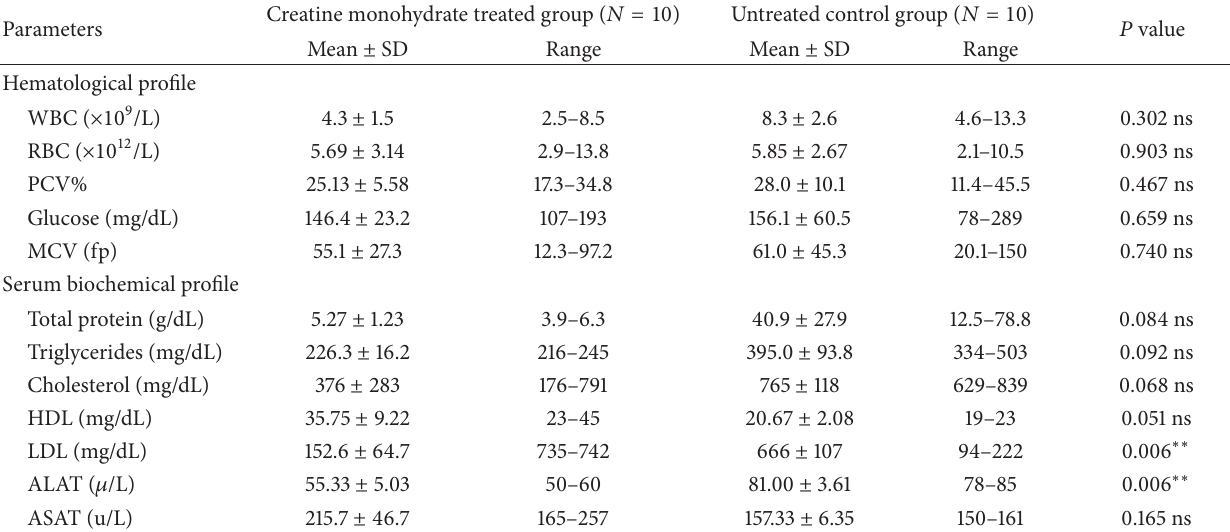
Table 4: Comparison of various hematological and serum biochemical parameters between 2% creatine monohydrate treated and untreated (control) male albino mice for 12 weeks: data is expressed as mean ± standard